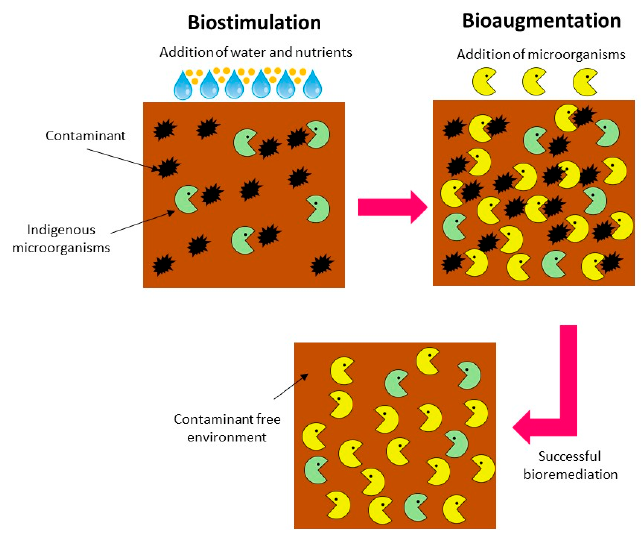
Figure 8. Comparison between Bioaugmentation and Biostimulation techniques (adapted from